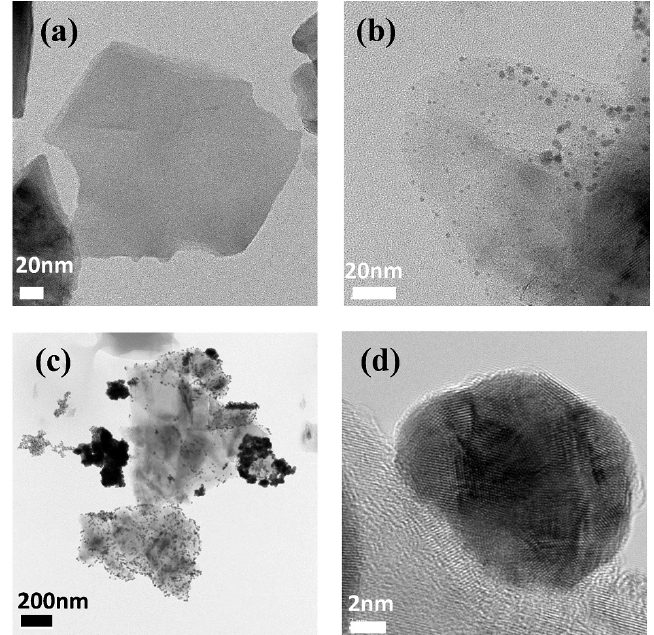
Figure 2. The TEM images of ( a ) MoS 2 nanosheets; ( b and c ) AuNP@MoS 2 . The concentration of the Au ions were ( b ) 0.1 mg mL − 1 ; ( c ) 0.2 mg mL − 1 ; ( d ) High-resolution image of a typical Au NP attached on the MoS 2 surface.